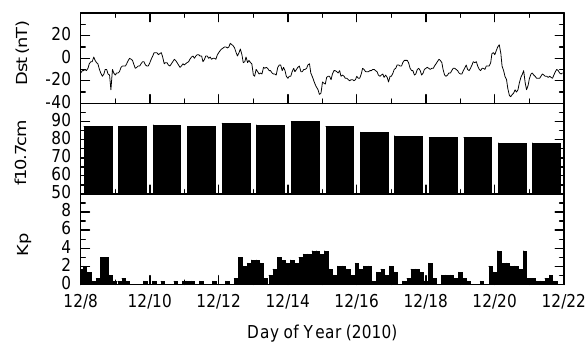
Fig. 19. VTEC time series above the Japan epicenter during 8 De- cember 2010 to 21 December 2010. Symbols in this figure are the same as those in Fig.